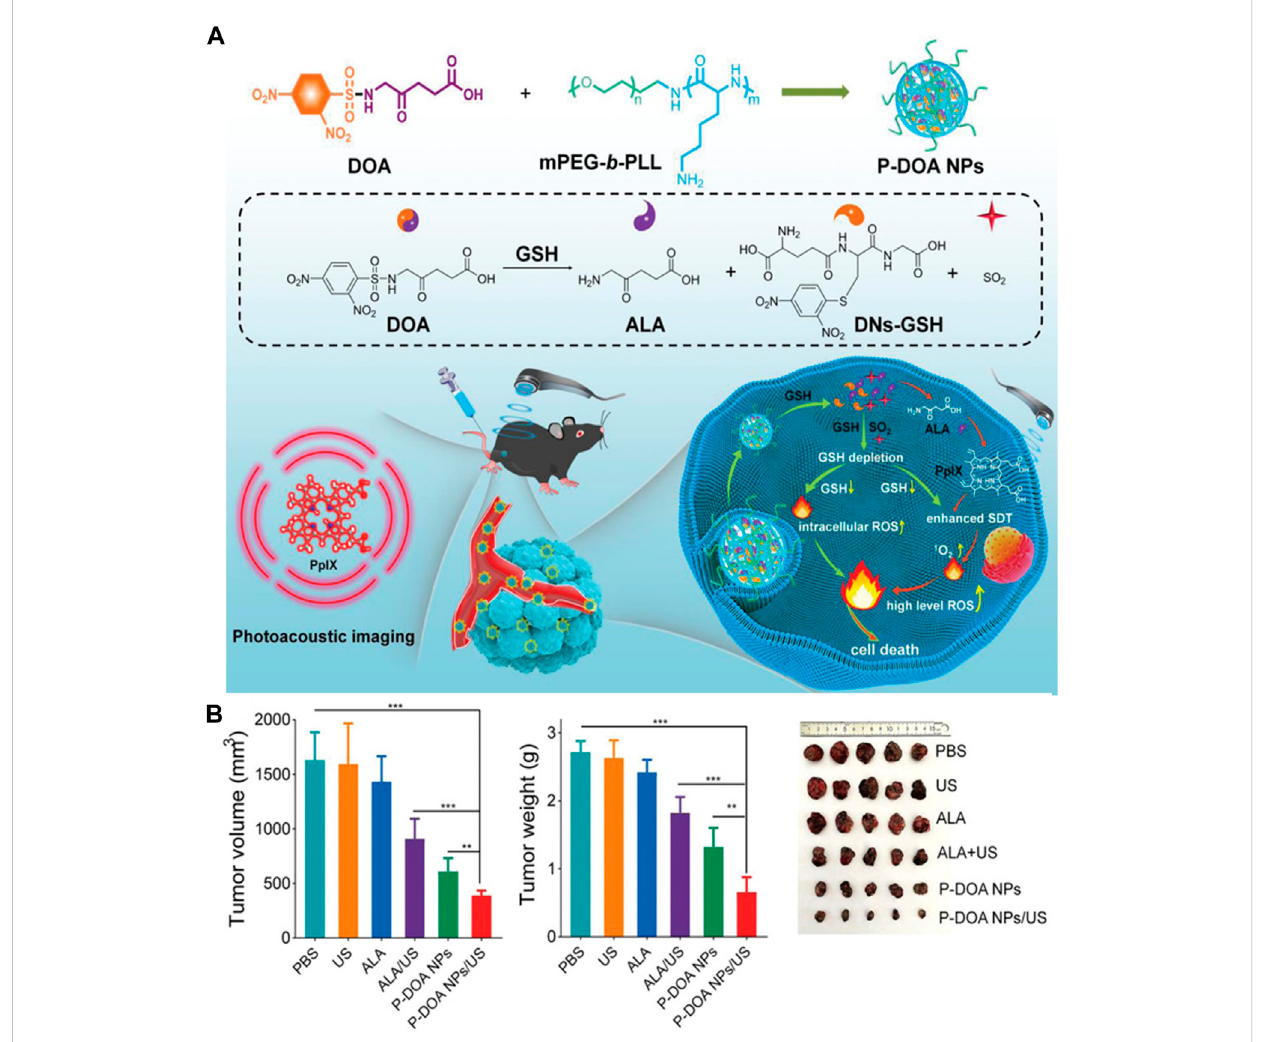
FIGURE 7 (A) Design and mechanism of GSH-responsive P-DOA NPs; (B) Relative tumor volume, weight and photographs of resected tumors in B16F10tumor-bearingmiceaftertreatmentsonday15.(UniteStates:ultrasound).Adaptedfromref.(Sunetal.,2022).Copyright2022WILEY-VCHVerlag GmbH & Co., KGaA,